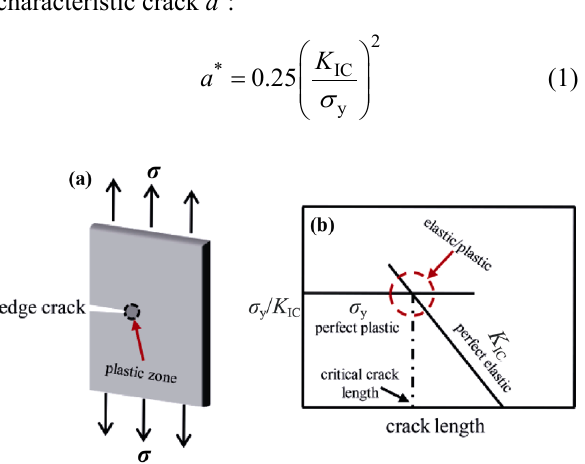
Fig. 1 (a) Tensile plate specimen fracture failure with edge crack, and (b) the two different fracture criteria associated with tensile yield strength σ y and the plane strain fracture toughness K IC